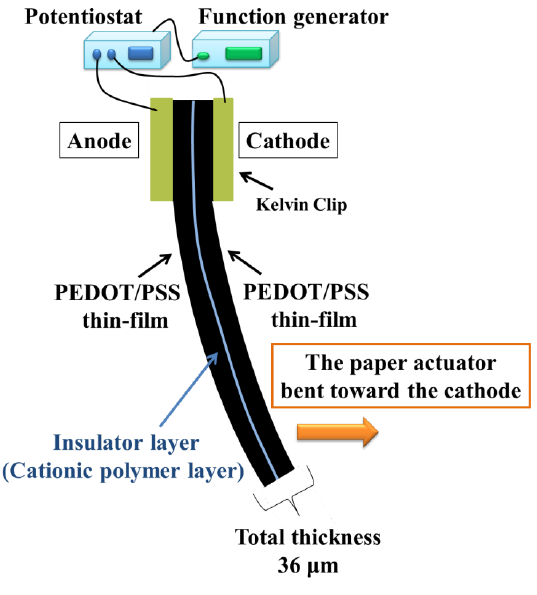
Figure 2. Schematic illustration of the motion of the paper